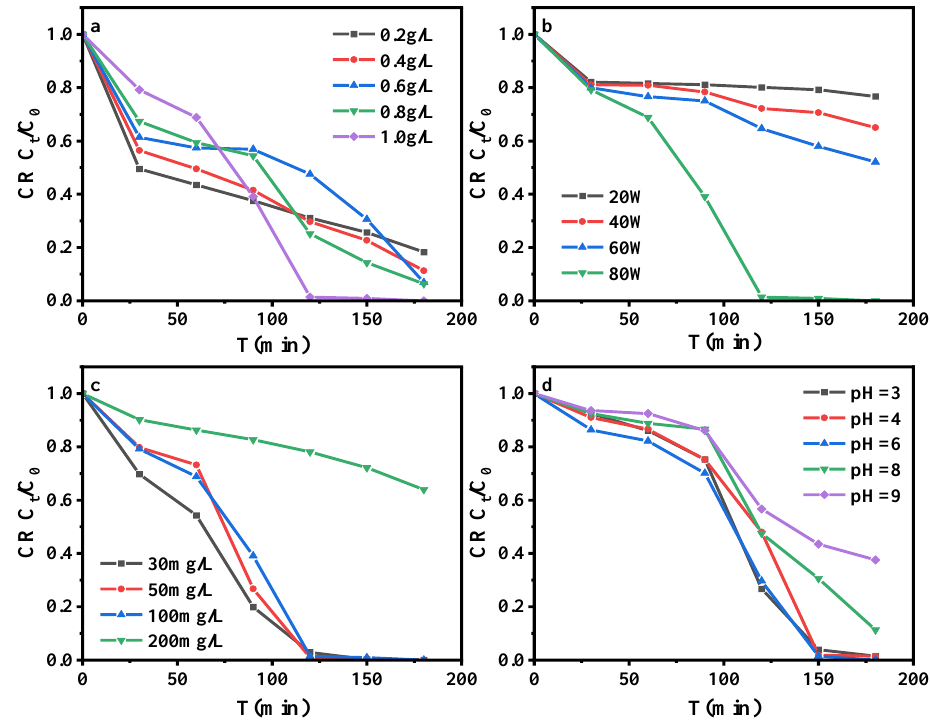
Figure 4. Effects of ( a ) Solid–liquid ratio; ( b ) Light intensity; ( c ) CR concentration; and ( d ) initial pH on CR removal efficiency. Reaction conditions: light intensity = 80 W; [CR] = 100 mg/L; pH = 6 for ( a ), [CaWO 4 ] = 1.0 g/L; [CR] = 100 mg/L; pH = 6 for ( b ), [CaWO 4 ] = 1.0 g/L; light intensity = 80 W; pH = 6 for ( c ), and [CaWO 4 ] = 1.0 g/L; light intensity = 80 W; [CR] = 100 mg/L for ( d ).